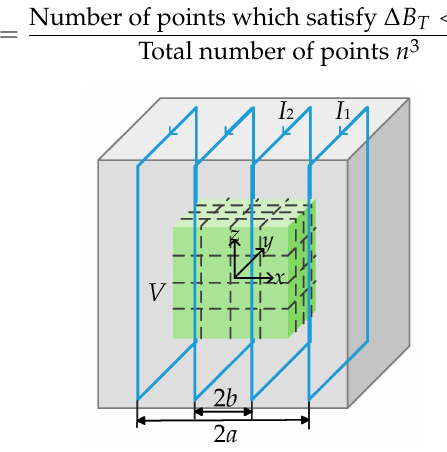
Figure 6. Coil structure diagram.